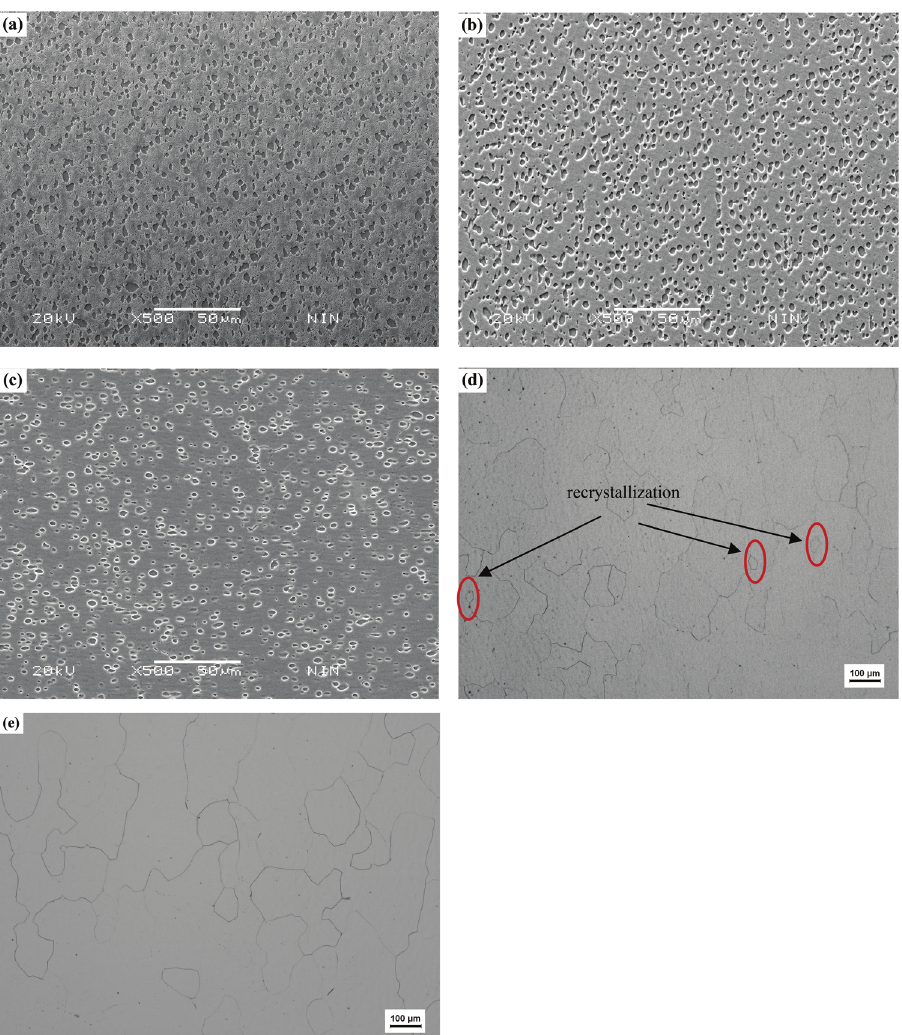
Figure 13: Microstructure of Ti555211 alloy at the strain rate of 0001 s − 1 : (a) 750°C; (b) 800°C; (c) 850°C; (d) 900°C; (e)